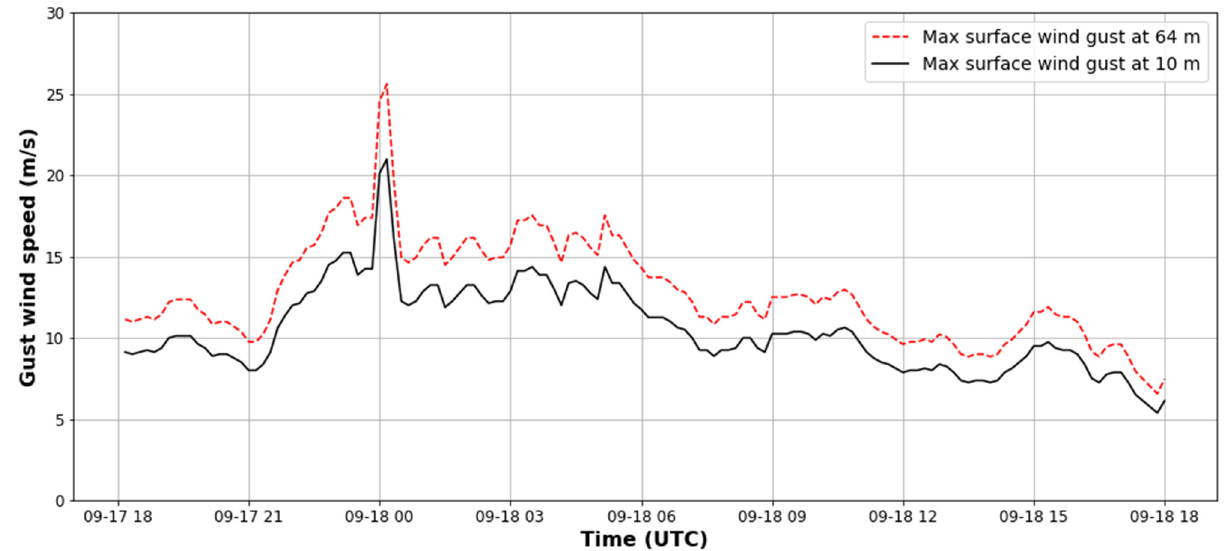
Figure 10. Comparison between NWP gust wind speed timeseries at 10 m and 64 m above the ground.